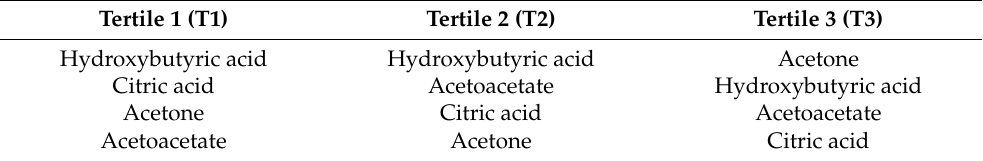
Note: Tertile 1 = lowest % TWL; tertile 2 = middle %TWL; tertile 3 = highest